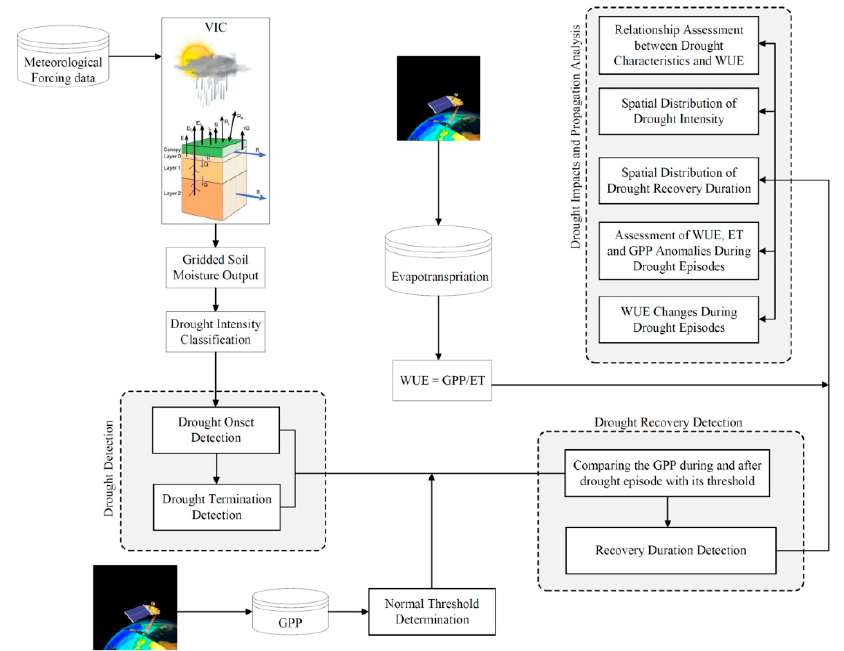
Figure 1. The framework for analyzing terrestrial drought recovery considering Gross Primary Productivity (GPP) and assessing Water Use Efficiency (WUE) response to drought and decomposing the influential factors.